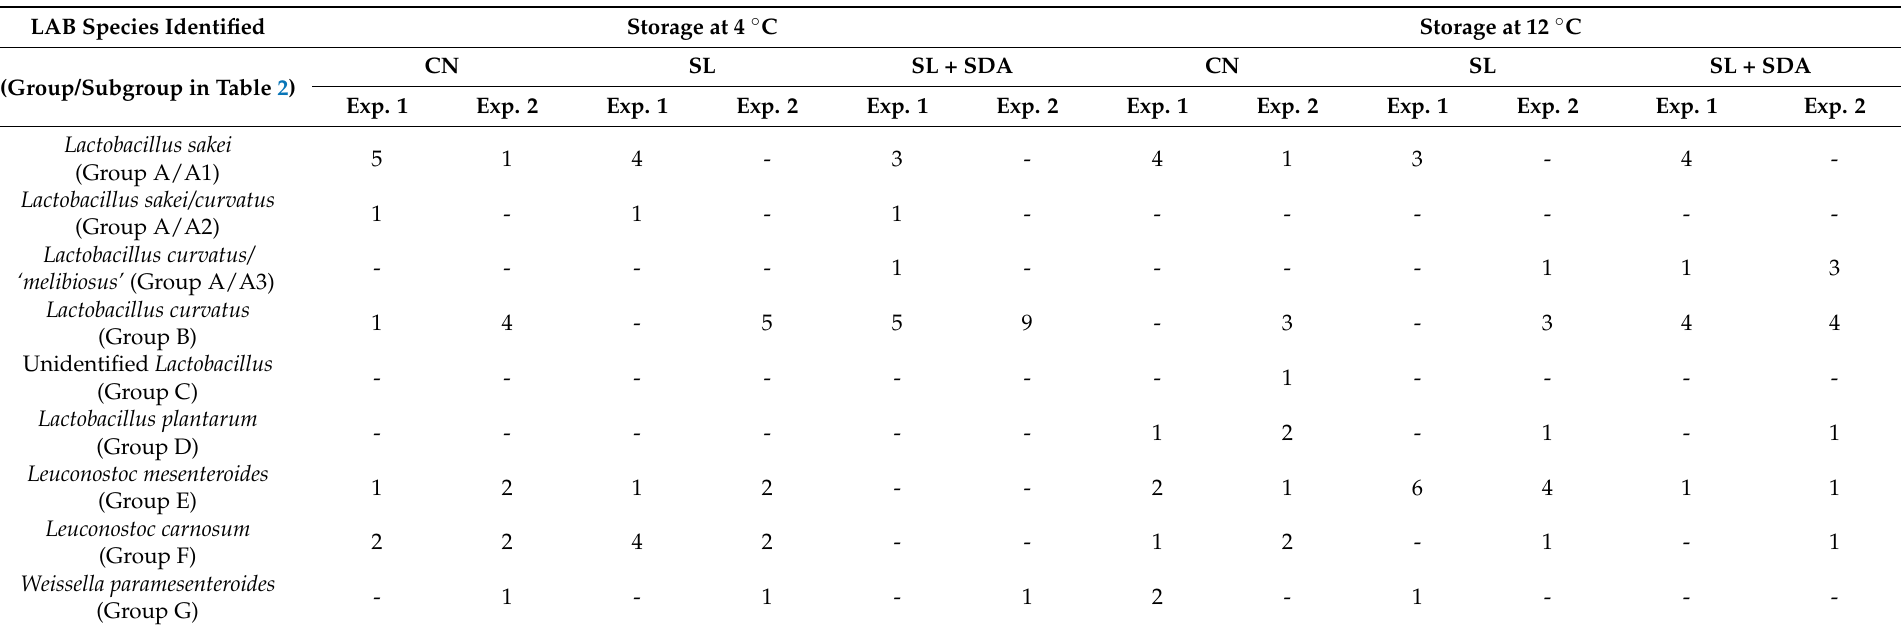
Table 4. Temperature-dependent and treatment-dependent LAB species distribution of 120 spoilage TSAYE isolates from two experimental trials of frankfurters manufactured with or without organic acid salts and stored at 4 ◦ C and 12 ◦ C in vacuum packages for 90 days a